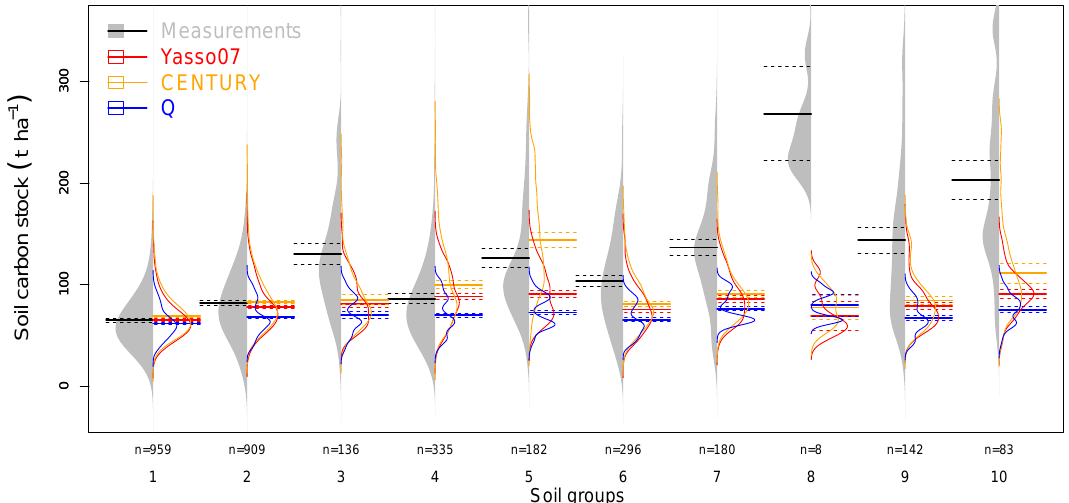
Figure 3. Bean plot of distributions of the soil carbon (tCha − 1 ) measurements (gray fill) and estimates for 10 physicochemical groups. The full and dashed horizontal lines represent the group means and their confidence intervals. The n is the number of samples. For description of group levels of SOC stocks, moisture, and fertility see Fig. 2 and Table